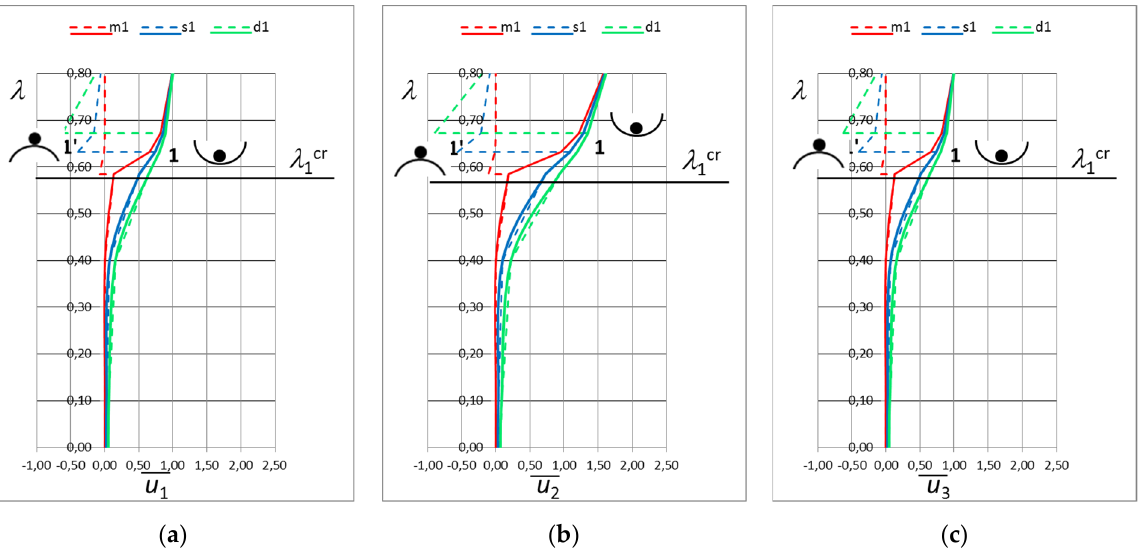
Figure 6. Equilibrium path obtained for small, medium and large amplitudes of the geometrical imperfections in the shape of the first buckling mode, respectively ( m 1, s 1 and d 1); displacement of the node: ( a ) No. 1, ( b ) No. 2, ( c ) No. 3.